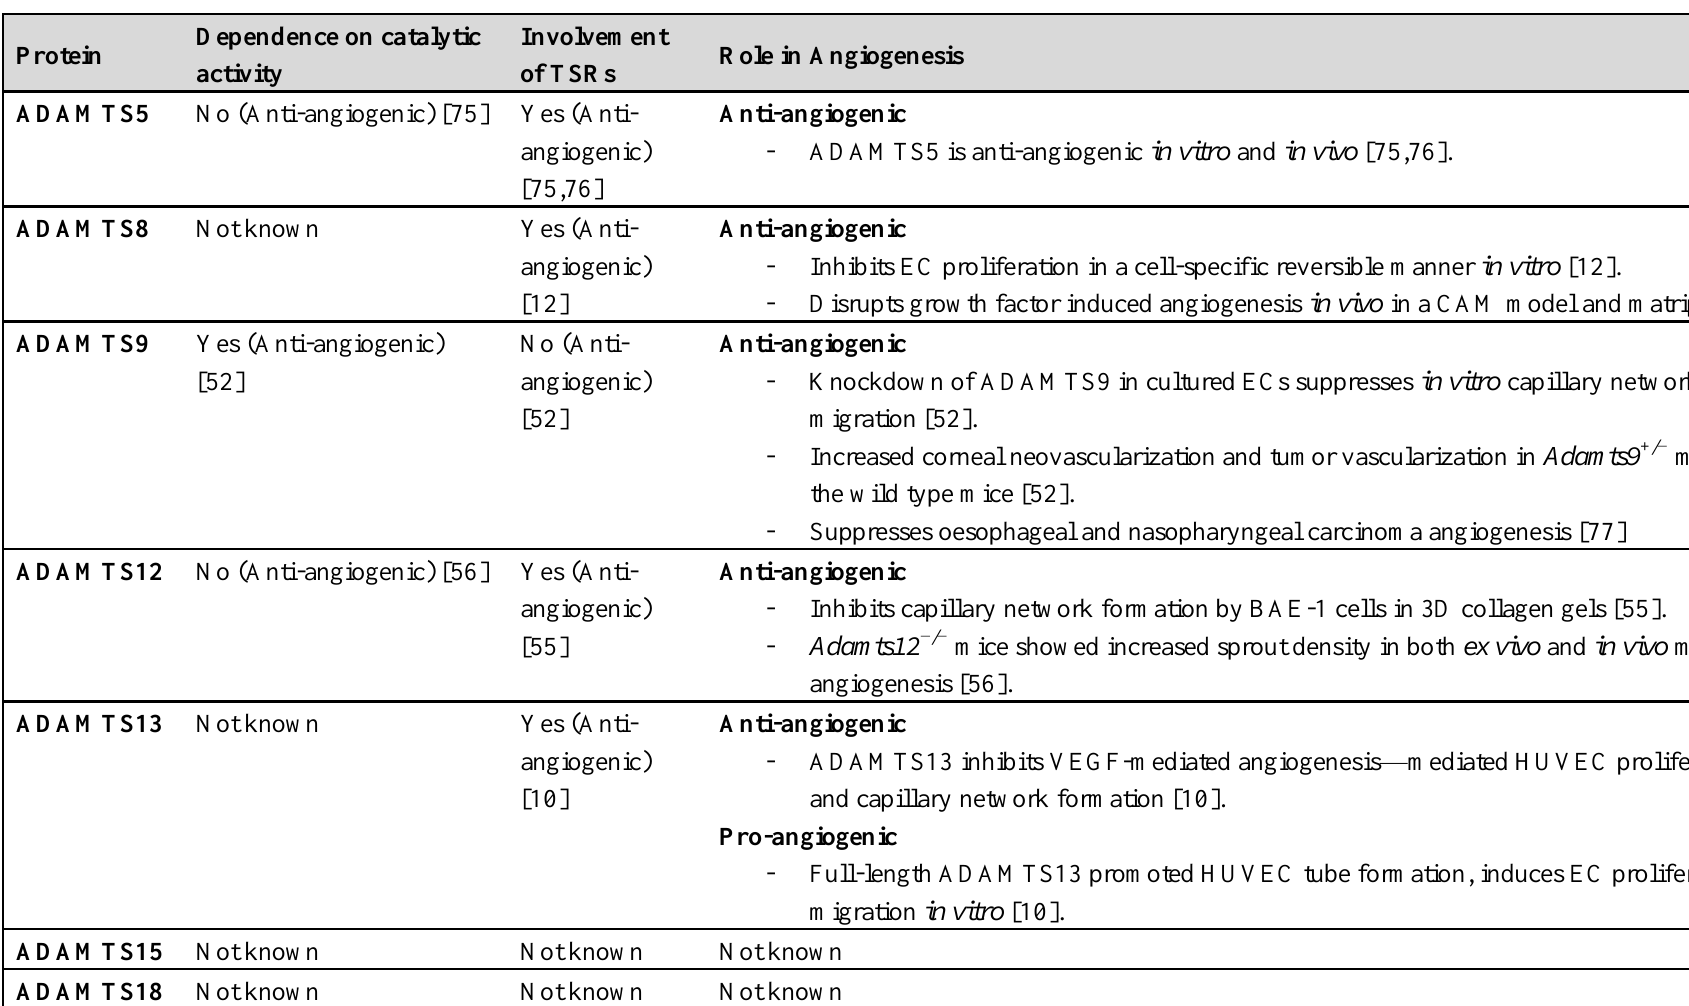
Full-length ADAMTS13 promoted HUVEC tube formation, induces EC proliferation and migration in vitro